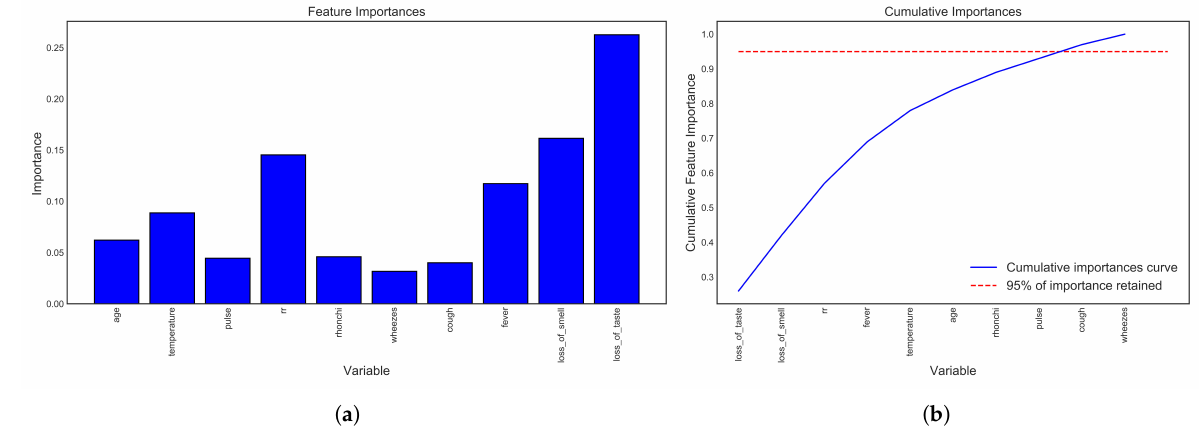
Figure 7. Feature importance and cumulative importance using XGB. The most important feature is loss_of_test, which is a noteworthy discovery from the dataset investigation. Then, ( a ) showed the selected 10 critical features, and ( b ) visualizes the cumulative feature importance curve, which also indicates that it grows to 95% above.